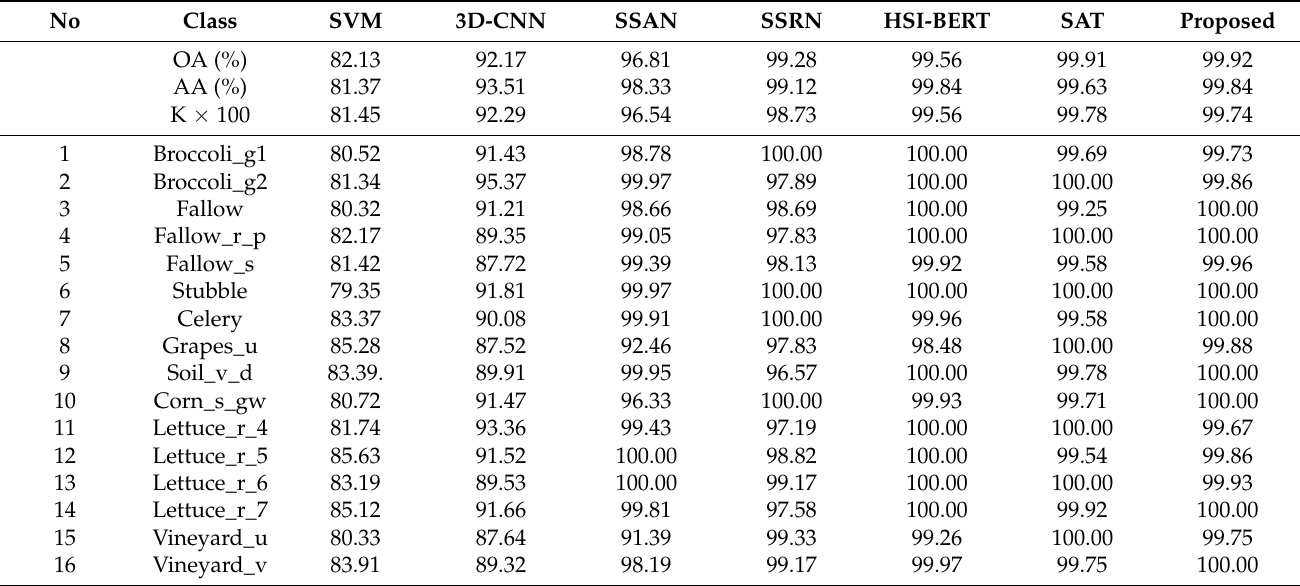
Table 5. Classification results of various methods for the SA Dataset.